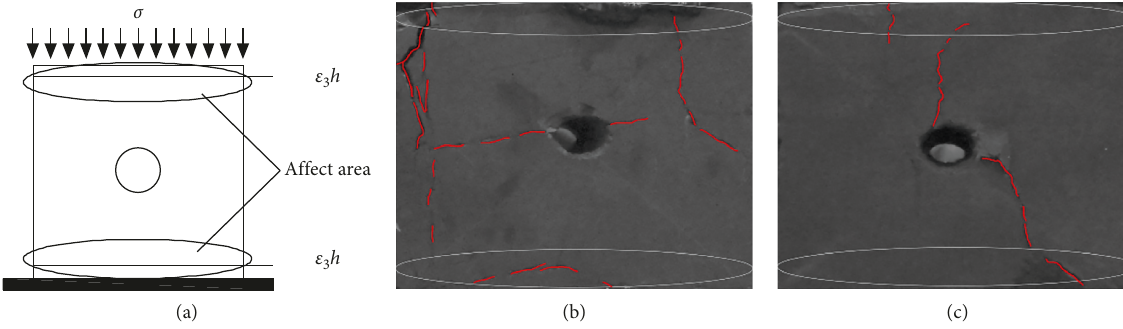
Figure 13: Mechanical model of even distribution of load. (a) Mechanical model; (b) coal sample; (c) briquette